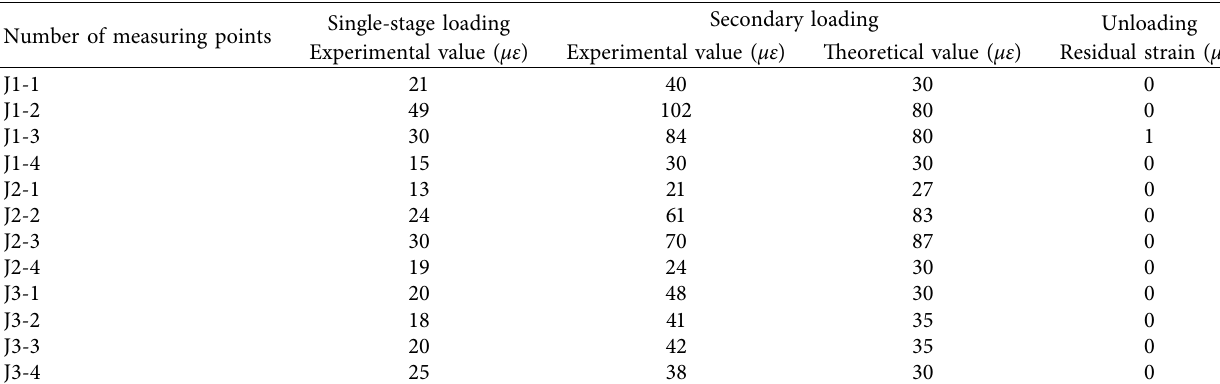
Figure 9: Steps of the static load test. (a) Single-stage loading. (b) Secondary loading. Table 1: Theory and experimental strain values.